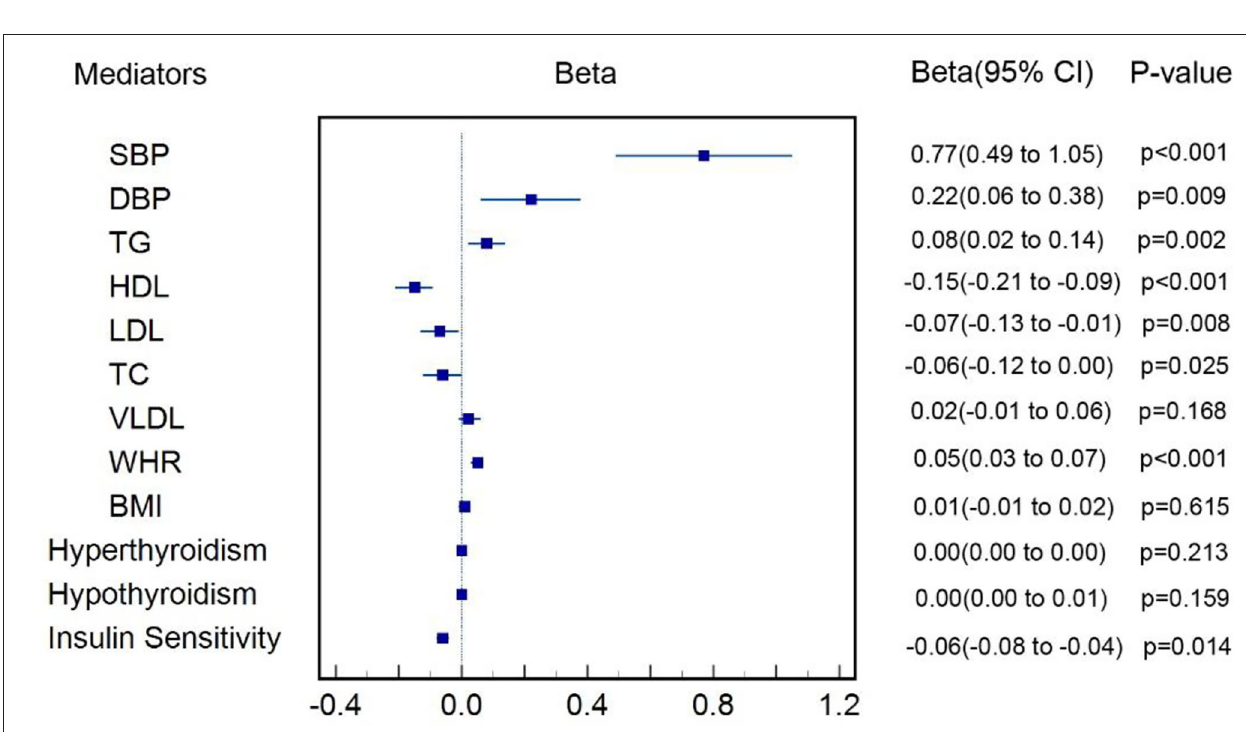
FIGURE 2 | Estimate of causal effect of T2DM on cardiometabolic